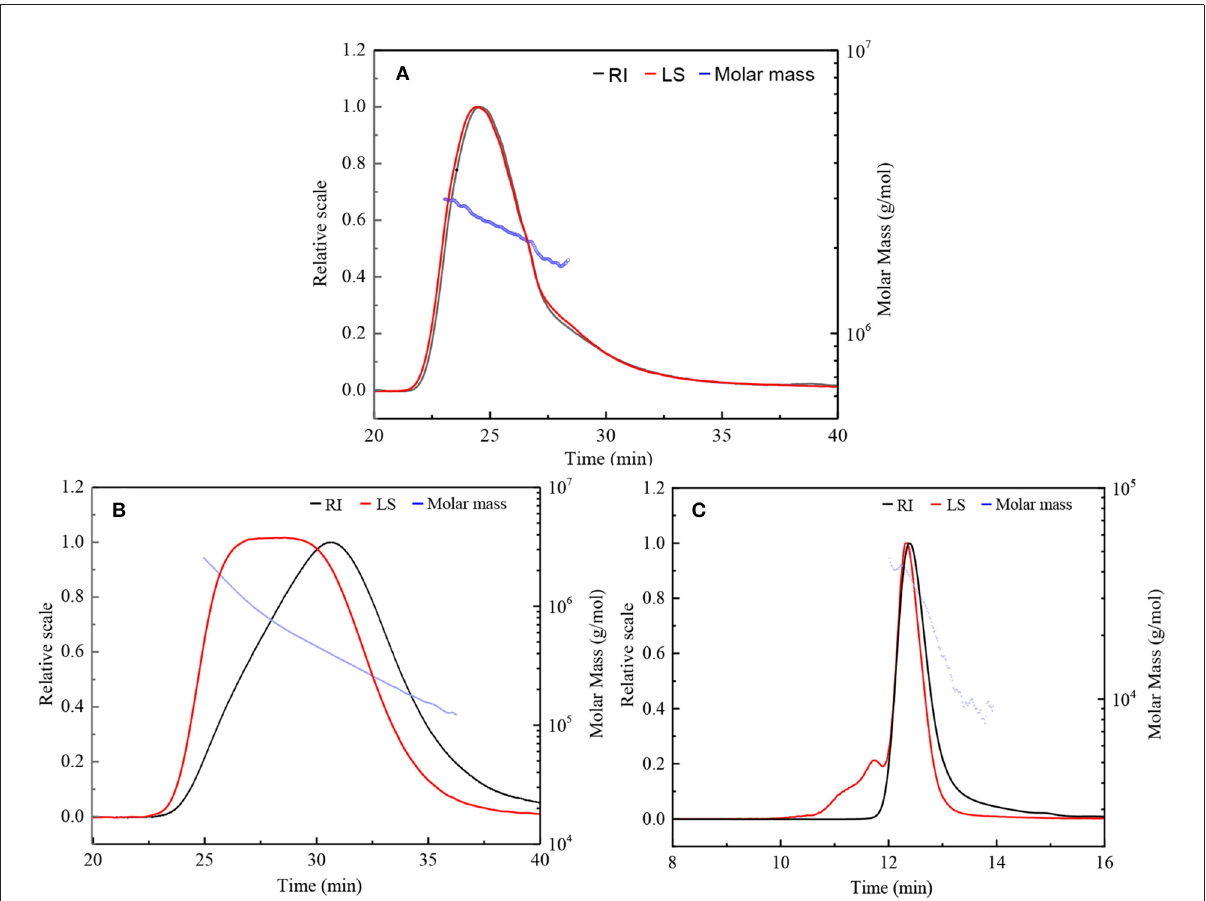
FIGURE2 HPSEC elution profiles and molar mass distributions of three fractions. (A,B) Represents HPSEC elution profile and molar mass of GLP and GLPC based on columns G6000 PW XL and G4000 PW XL in series connection system, respectively. (C) Represent HPSEC elution profile and molar mass